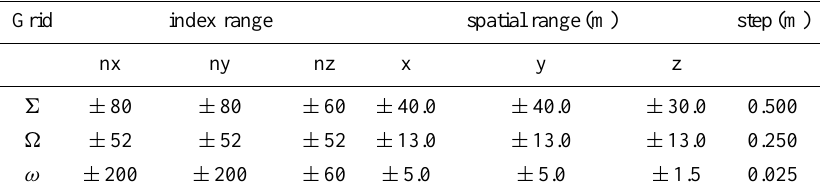
Table 1. Characteristics of the computational grids Grid index range spatial range(m) step(m) nx ny nz x y z 6 ± 80 ± 80 ± 60 ± 40.0 ± 40.0 ± 30.0 0.500 (cid:127) ± 52 ±